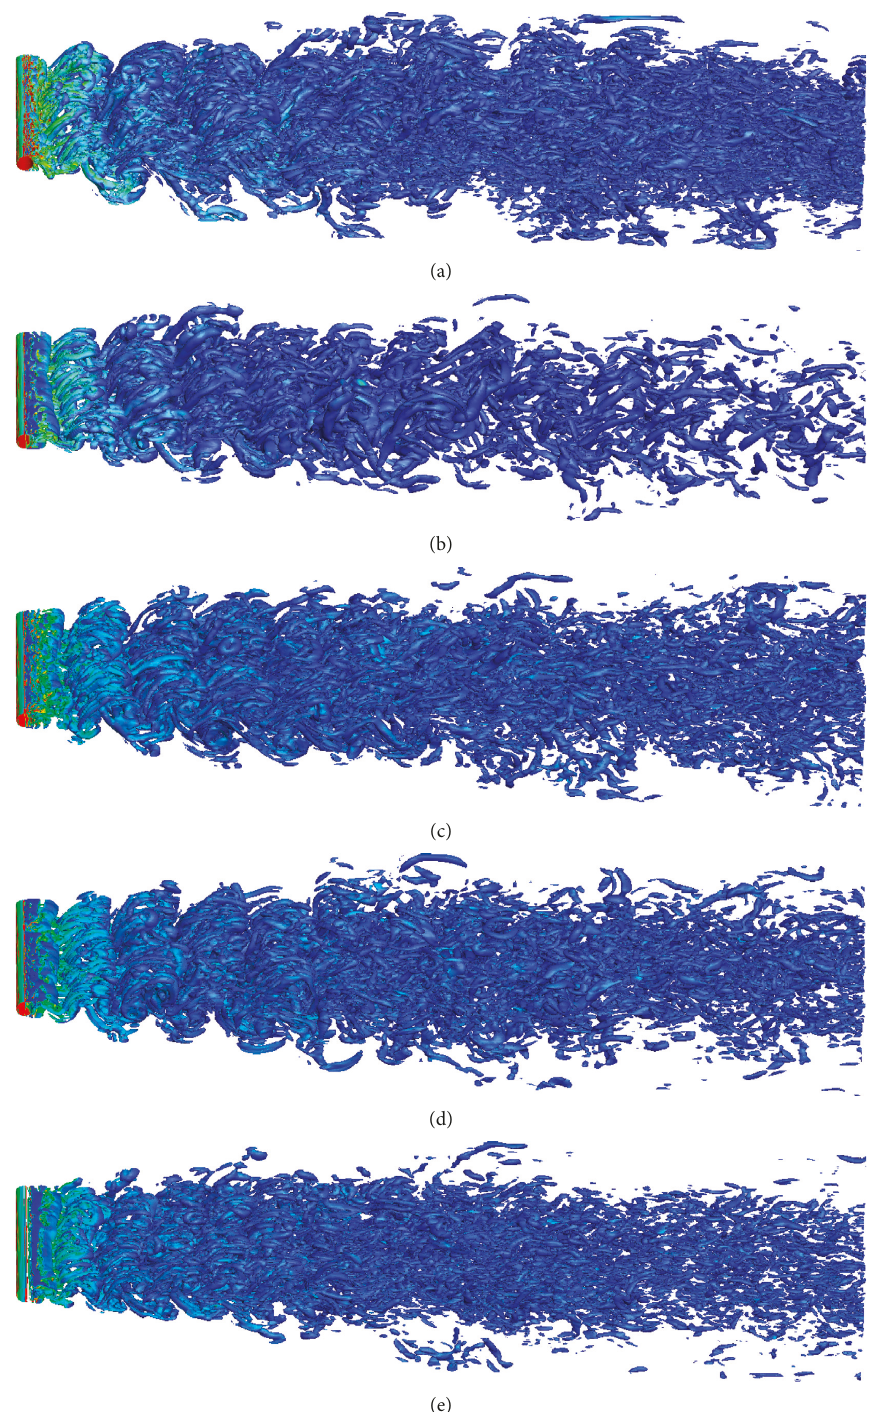
Figure 4: Instantaneous vortex structure of the cylindrical turbulent models of (a) LES, (b) SAS, (c) IDDES sst-k ω , (d) DDES sst-k ω , and (e) DDES R-k ε